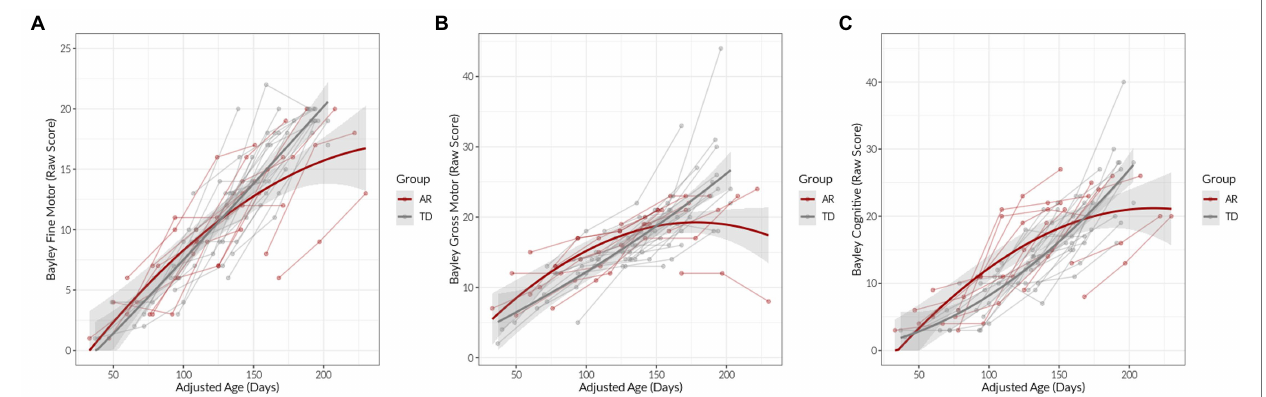
FIGURE 2 | Developmental scores measured over age (adjusted for prematurity as appropriate), for the at risk (AR) and typically developing (TD) groups. Points indicate observed individual values. Lowess-smoothed lines with 95% confidence bands are also shown. (A) Bayley fine motor scale (raw score), (B) Bayley gross motor scale (raw score), (C) Bayley cognitive scale (raw